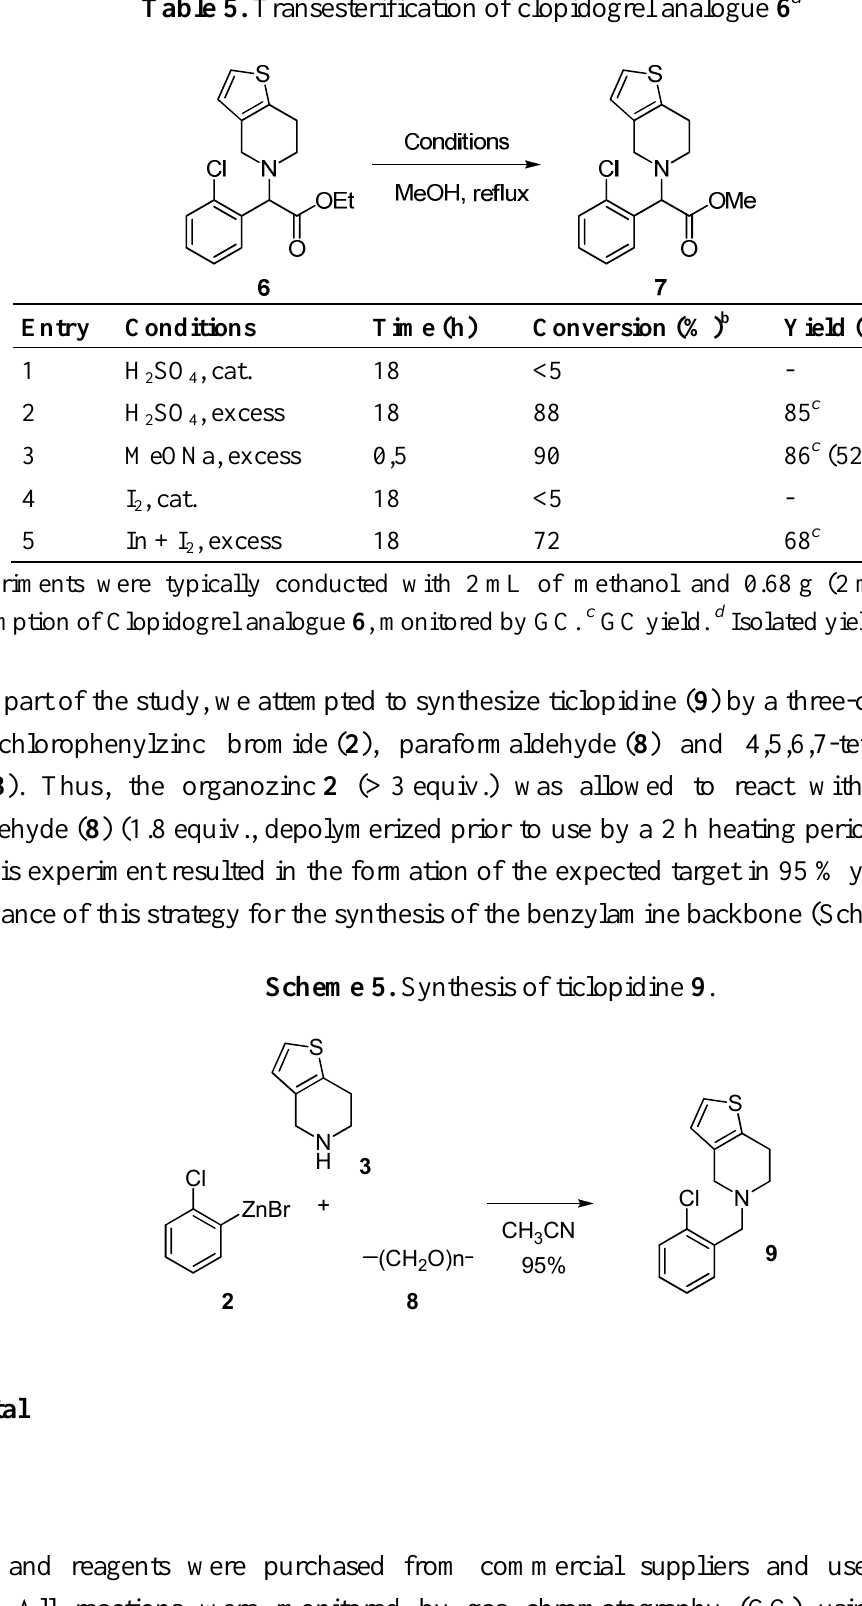
Table 5. Transesterification of clopidogrel analogue 6